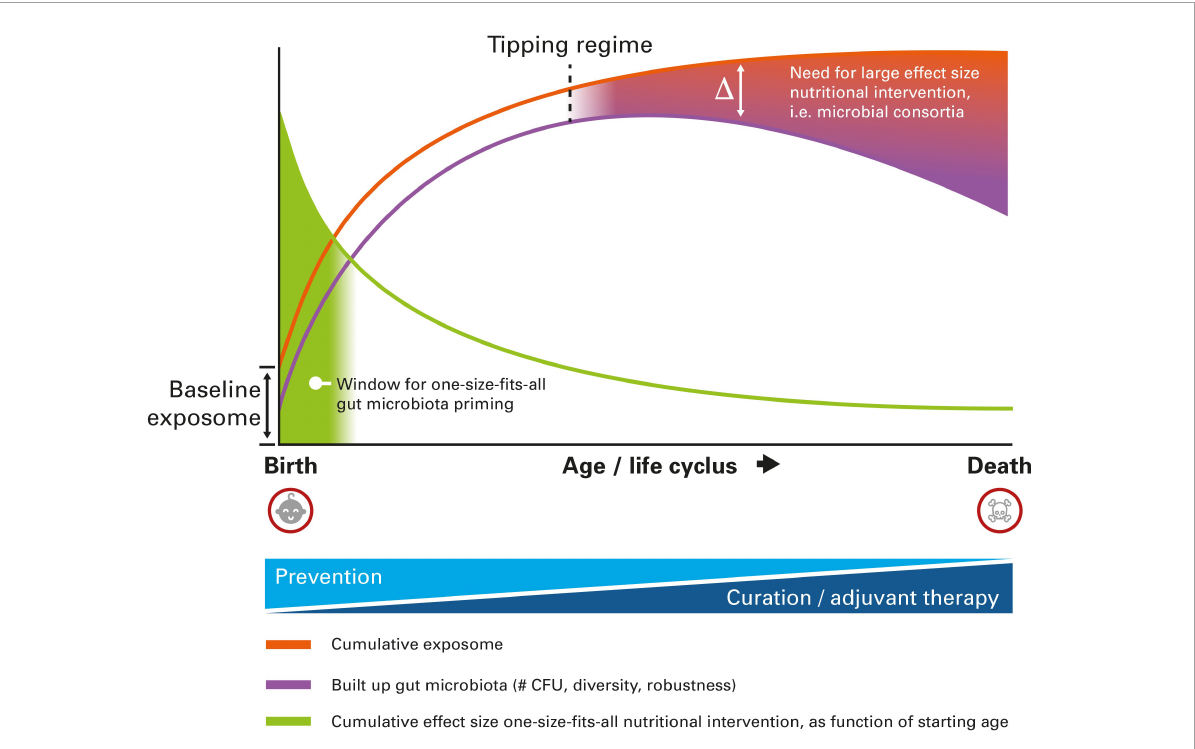
FIGURE1 Schematic representation of the different nutritional intervention modalities targeting the gut microbiota to reduce the burden of autoimmune disease, as a function of age. At very early age, one-size-fits-all intervention is still possible, whereas at older age a more personalized approach is needed, due to higher interindividual variation imposed by the cumulative exposome. For details, see